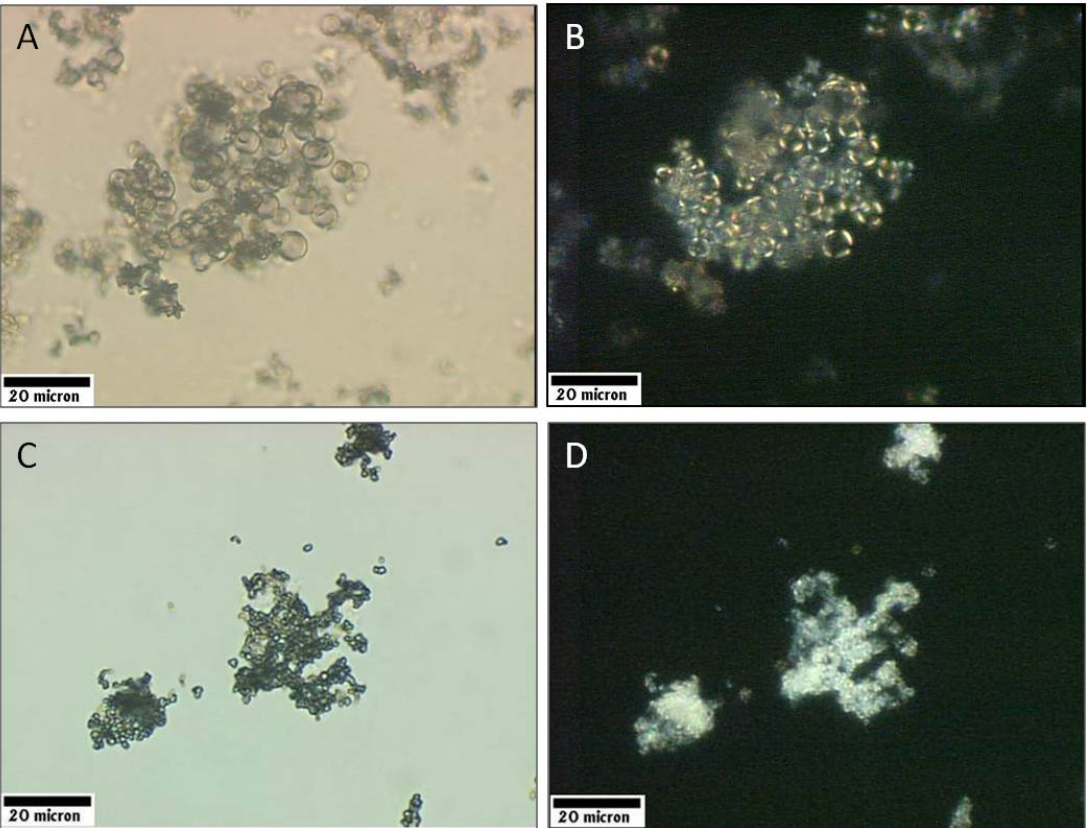
Figure 2 . Light microscopy images of CaCO 3 -coated emulsion droplets and liposomes. ( A ) Brightfield light microscopy of coated emulsion droplets. ( B ) Polarized light microscopy (PLM) of the same particles shown in ( A ). The visible portion (due to birefringence) displays a “Maltese Cross” pattern, indicating the product is crystalline with radial alignment of the polycrystals. ( C ) Brightfield light microscopy of coated liposomes. ( D ) PLM of the product seen in ( C ). Although very small, the clear interiors of the particles can be seen, suggesting a crystalline core-shell structure has been achieved.